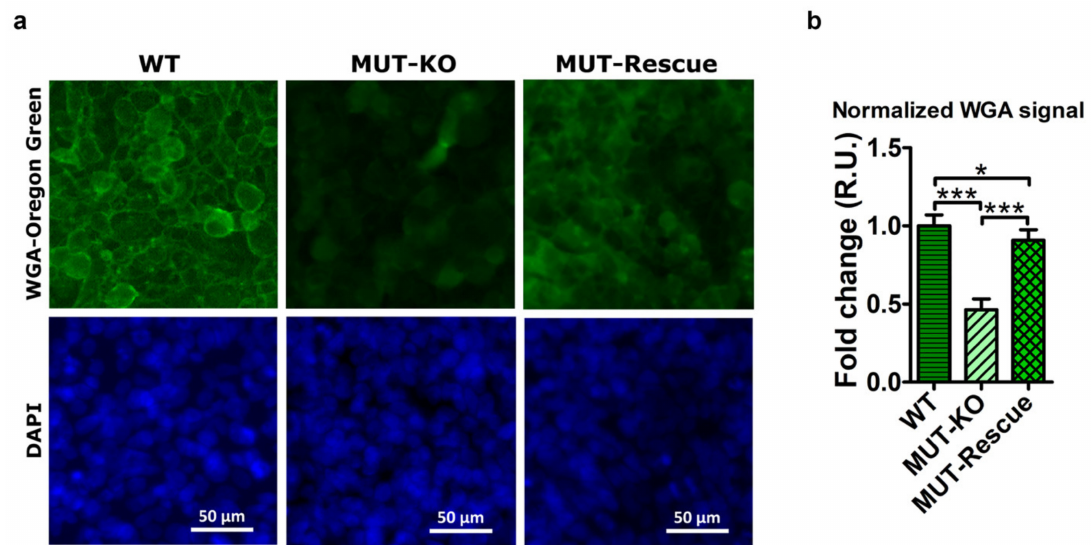
Figure 10. Microscopy analysis of fluorescent wheat germ agglutinin (WGA) staining in HEK 293 and genome-modified cells. ( a ) Microscopy images of WT, MUT-KO, and MUT-Rescue cells after staining with Oregon Green-labeled WGA and with DAPI. Cells were observed with a Leica DMI 4000 B inverted microscope equipped with Leica GFP and DAPI filter cubes, by using a 40 × objective and images were acquired with the Leica LAS AF software. ( b ) Quantitative analysis of fluorescent signals was performed in three independent biological replicates and three microscope fields were acquired for each biological replicate. The signal intensity of acquired micrographs was measured by the ImageJ software. WGA signals were normalized to DAPI signals and expressed as fold change (relative units, RU) with respect to values of WT cells. Data were reported as the mean values of three biological replicates and error bars represent SD. A one-way two-tail paired t -test was used to calculate the statistical significance of di ff erences between the three tested cell types. *: p < 0.05; ***: p <